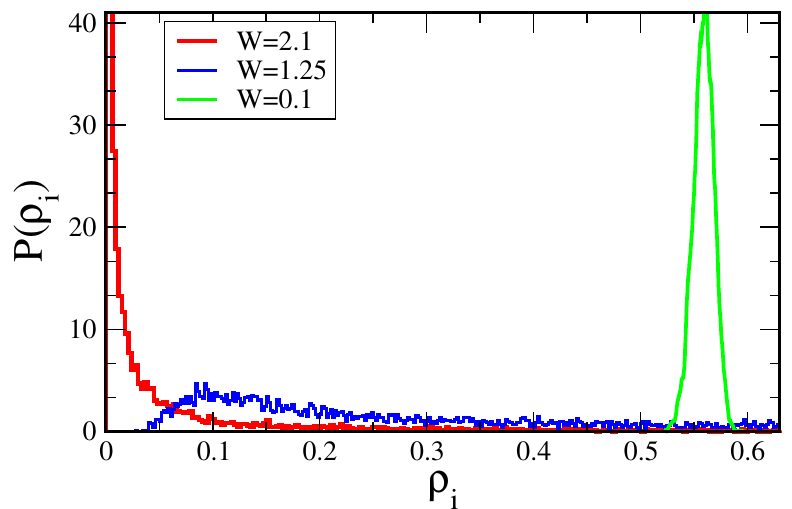
Figure 6. The evolution of the probability distribution function of the local DOS ρ i at the band center ( ω = 0) with disorder strength W . The data is the same as in Figure